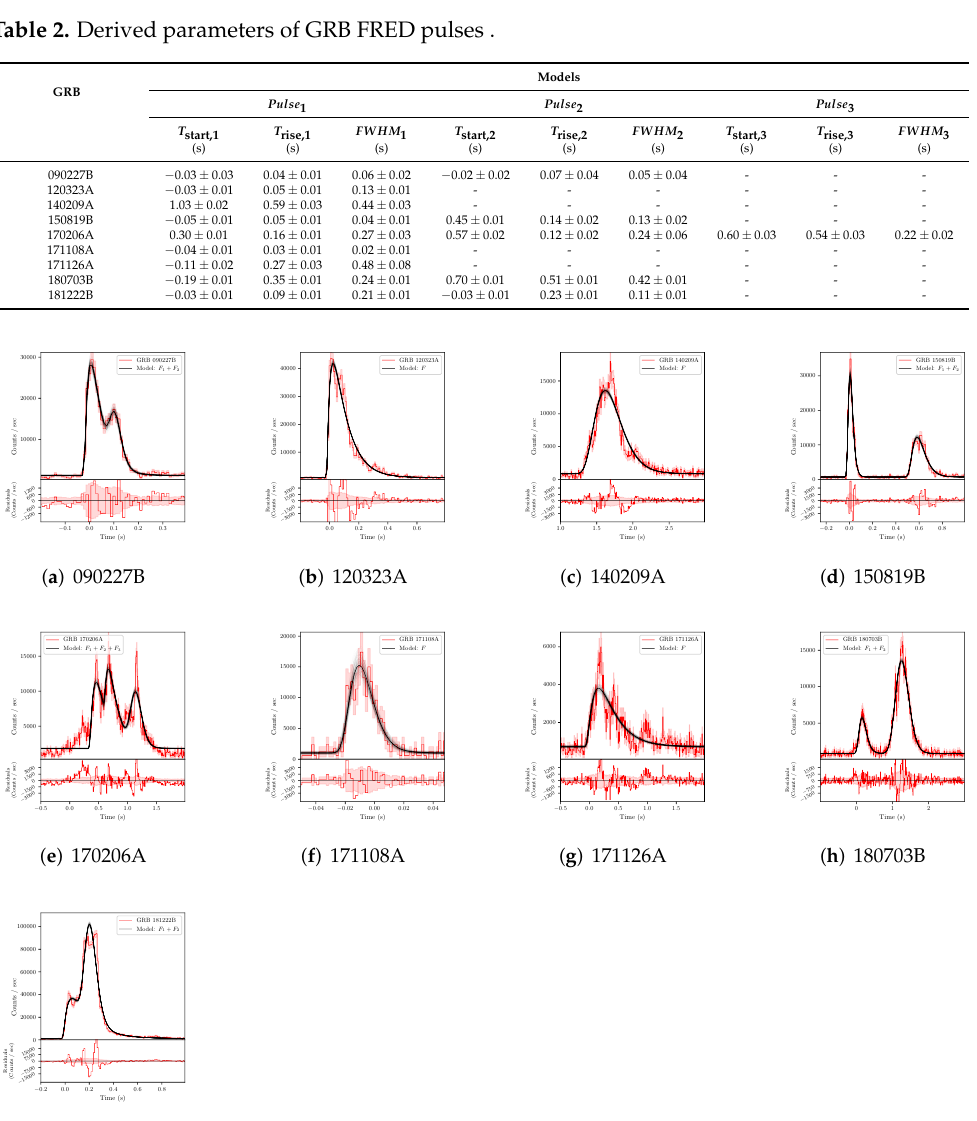
Figure 1. Observaional lightcurves in the energy band from 50 keV to 300 keV and the best-fit lines modelled by the FRED functions. For top pannel of each GRB, the red histogram represents 50–300 keV observational lightcurve, and solid black line is the best fit with the empirical function (FRED). The bottom pannel in ecah GRB is the residual between the observation and the fitting